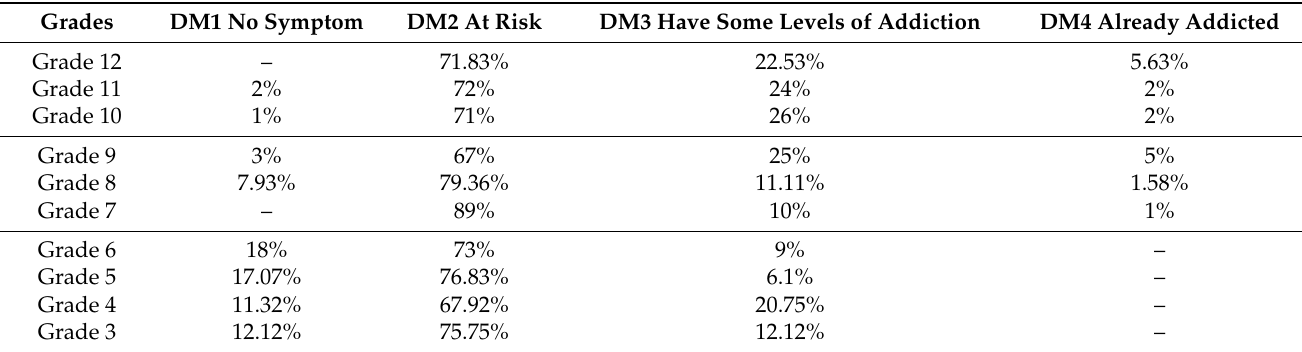
Table 8. The level of gaming among the students of grade 3 to grade